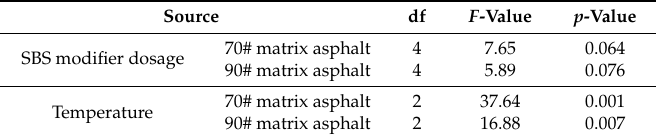
Table 3. Variance analysis of penetration for SBS modified asphalt.